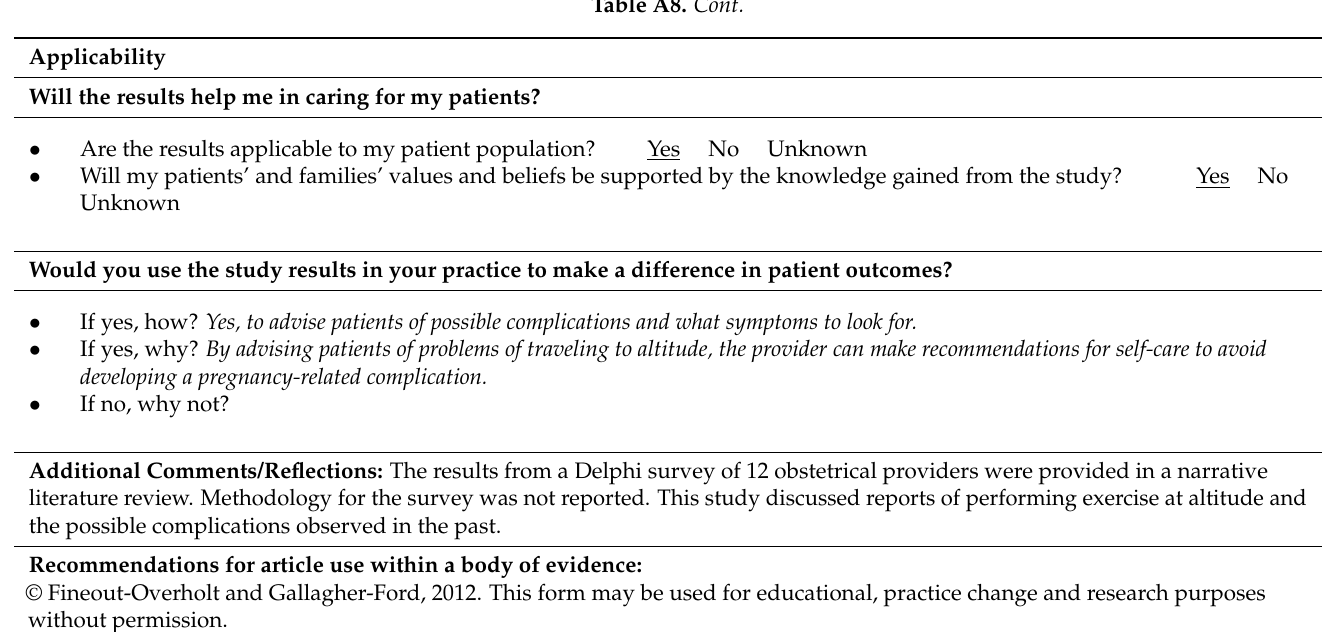
Table A9. JBI Critical Appraisal Checklist for quasi-experimental studies—Pivarnik et al. (1992) study. Citation: